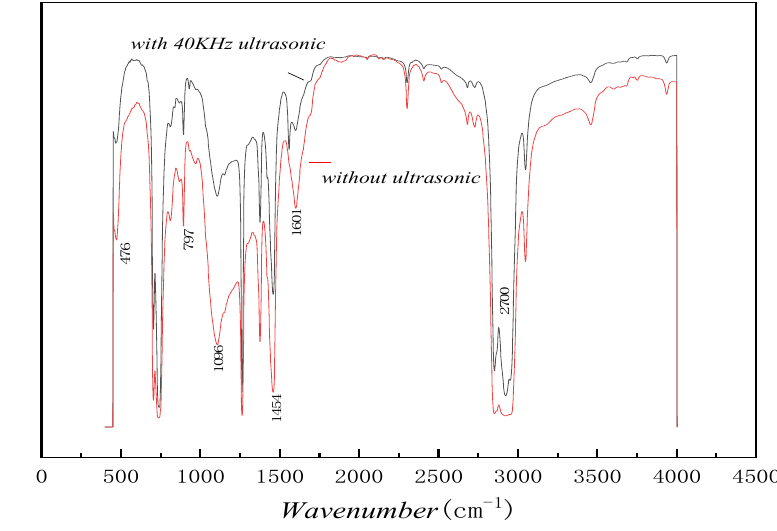
Figure 16. Infrared spectra of nanopitch before and after ultrasonic treatment.